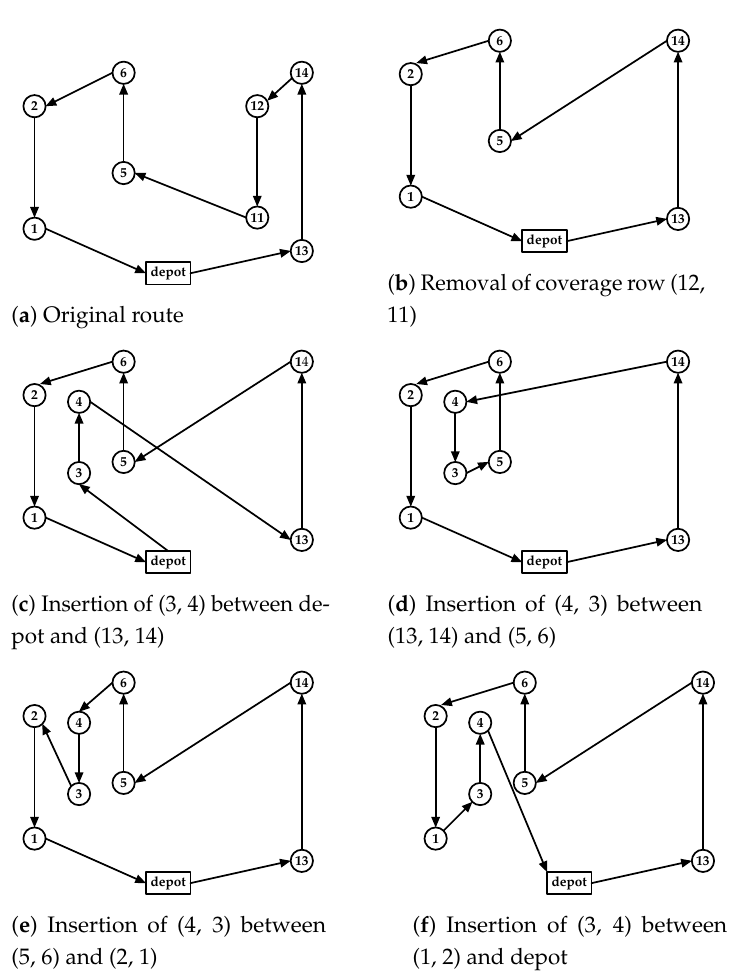
Figure 7. Example of link evaluation heuristic performed on Swap to compute the route.